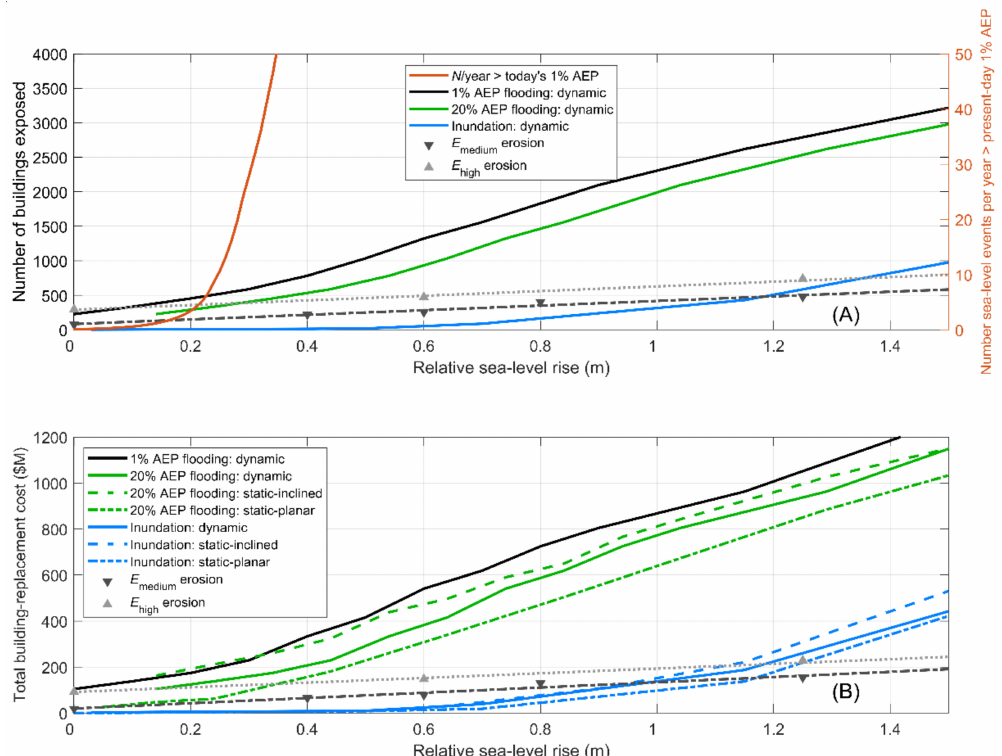
Figure 5. ( A ) Comparison of hydrodynamic model-derived building exposure to an “extreme” 1% AEP sea-level, 20% AEP sea-level and a typical high spring tide, for RSLR up to 1.5 m above present. In addition, shown are the E medium and E high coastal erosion scenarios and the increase in the annual expected number of exceedances (N) of the present-day 1% AEP elevation; ( B ) RSLR versus the building replacement value